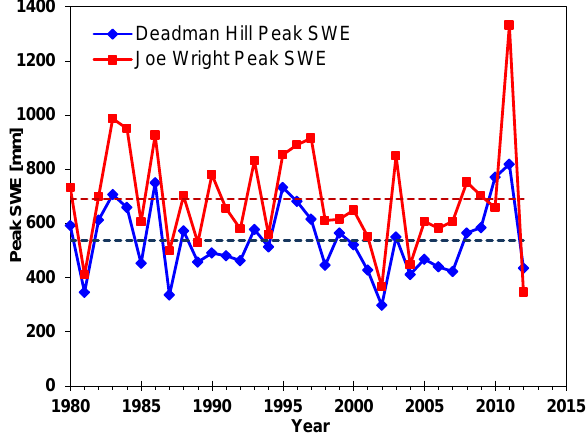
Fig. 2. Annual peak SWE and mean annual peak SWE (1980 to 2012) for Deadman Hill and Joe Wright SNOTEL